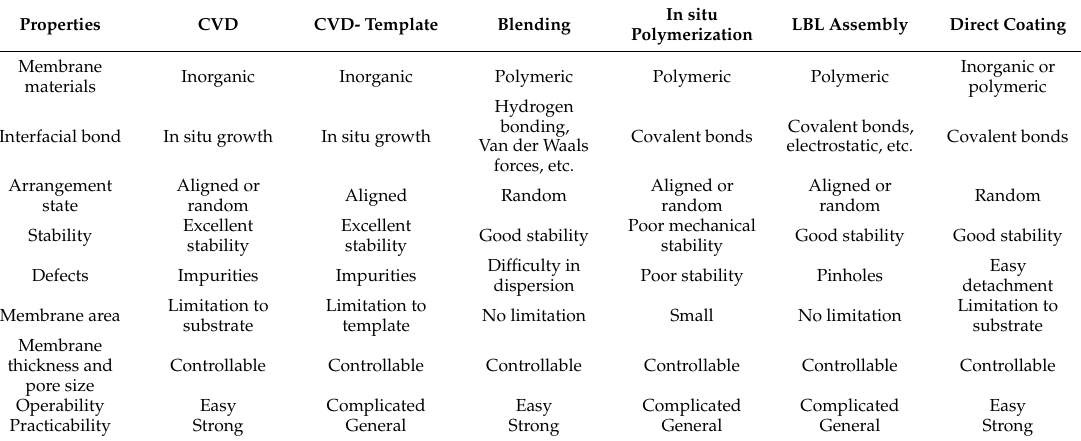
Table 3. Fabrication methods of CNTs-based composite